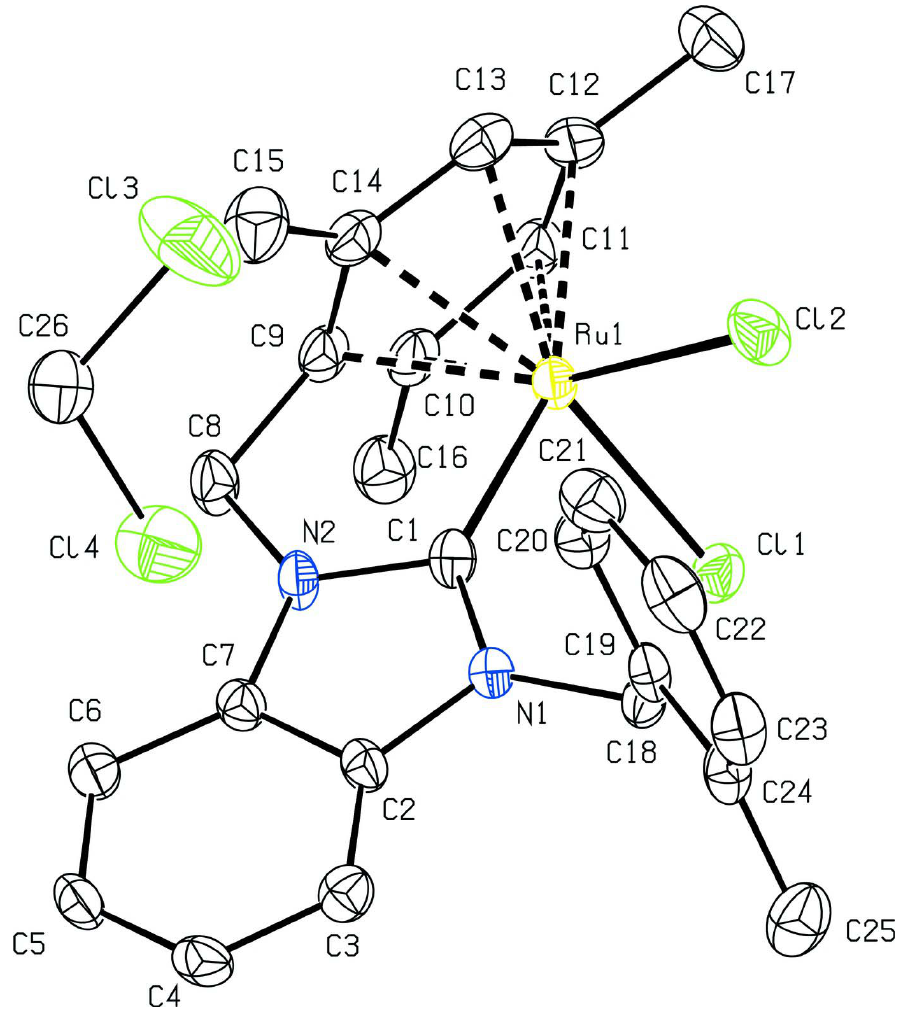
Figure 1 The molecular structure of the title compound, showing the atom-numbering scheme and displacement ellipsoids drawn at the 50% probability